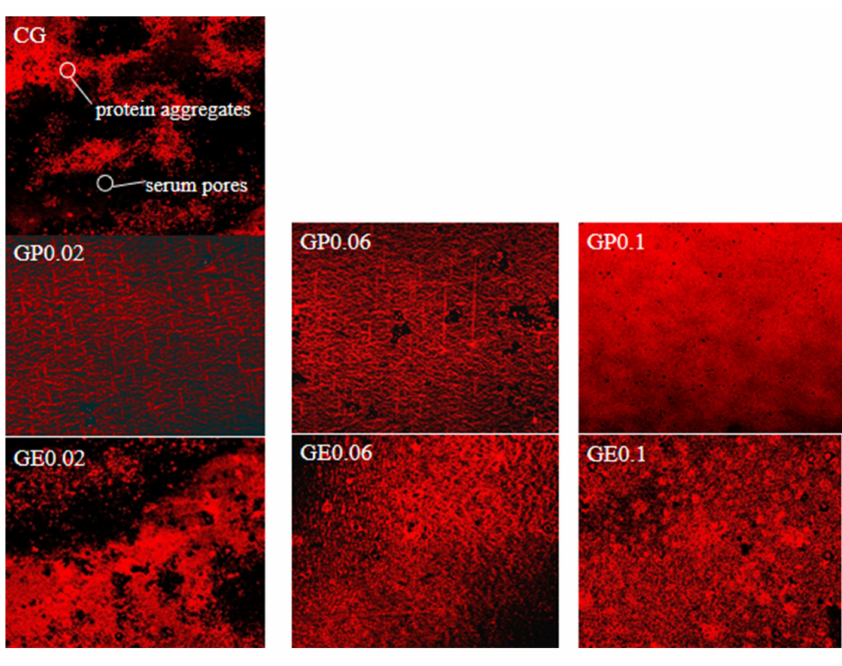
Figure 4. Microstructure of yogurt samples.